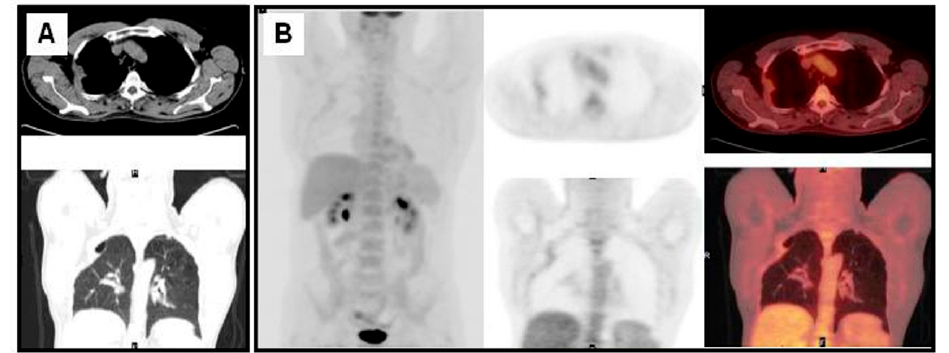
Figure 3. Patient with undifferentiated carcinoma of the right lung surgically treated seven years before followed by radiotherapy. In a context of pain and functional impotence of the right shoulder, a CT showed a suspicious image in the medial aspect of the lung near the right axilla and structural changes due to the previous surgery ( A ). 18 F-FDG PET/CT ruled out recurrence ( B ).